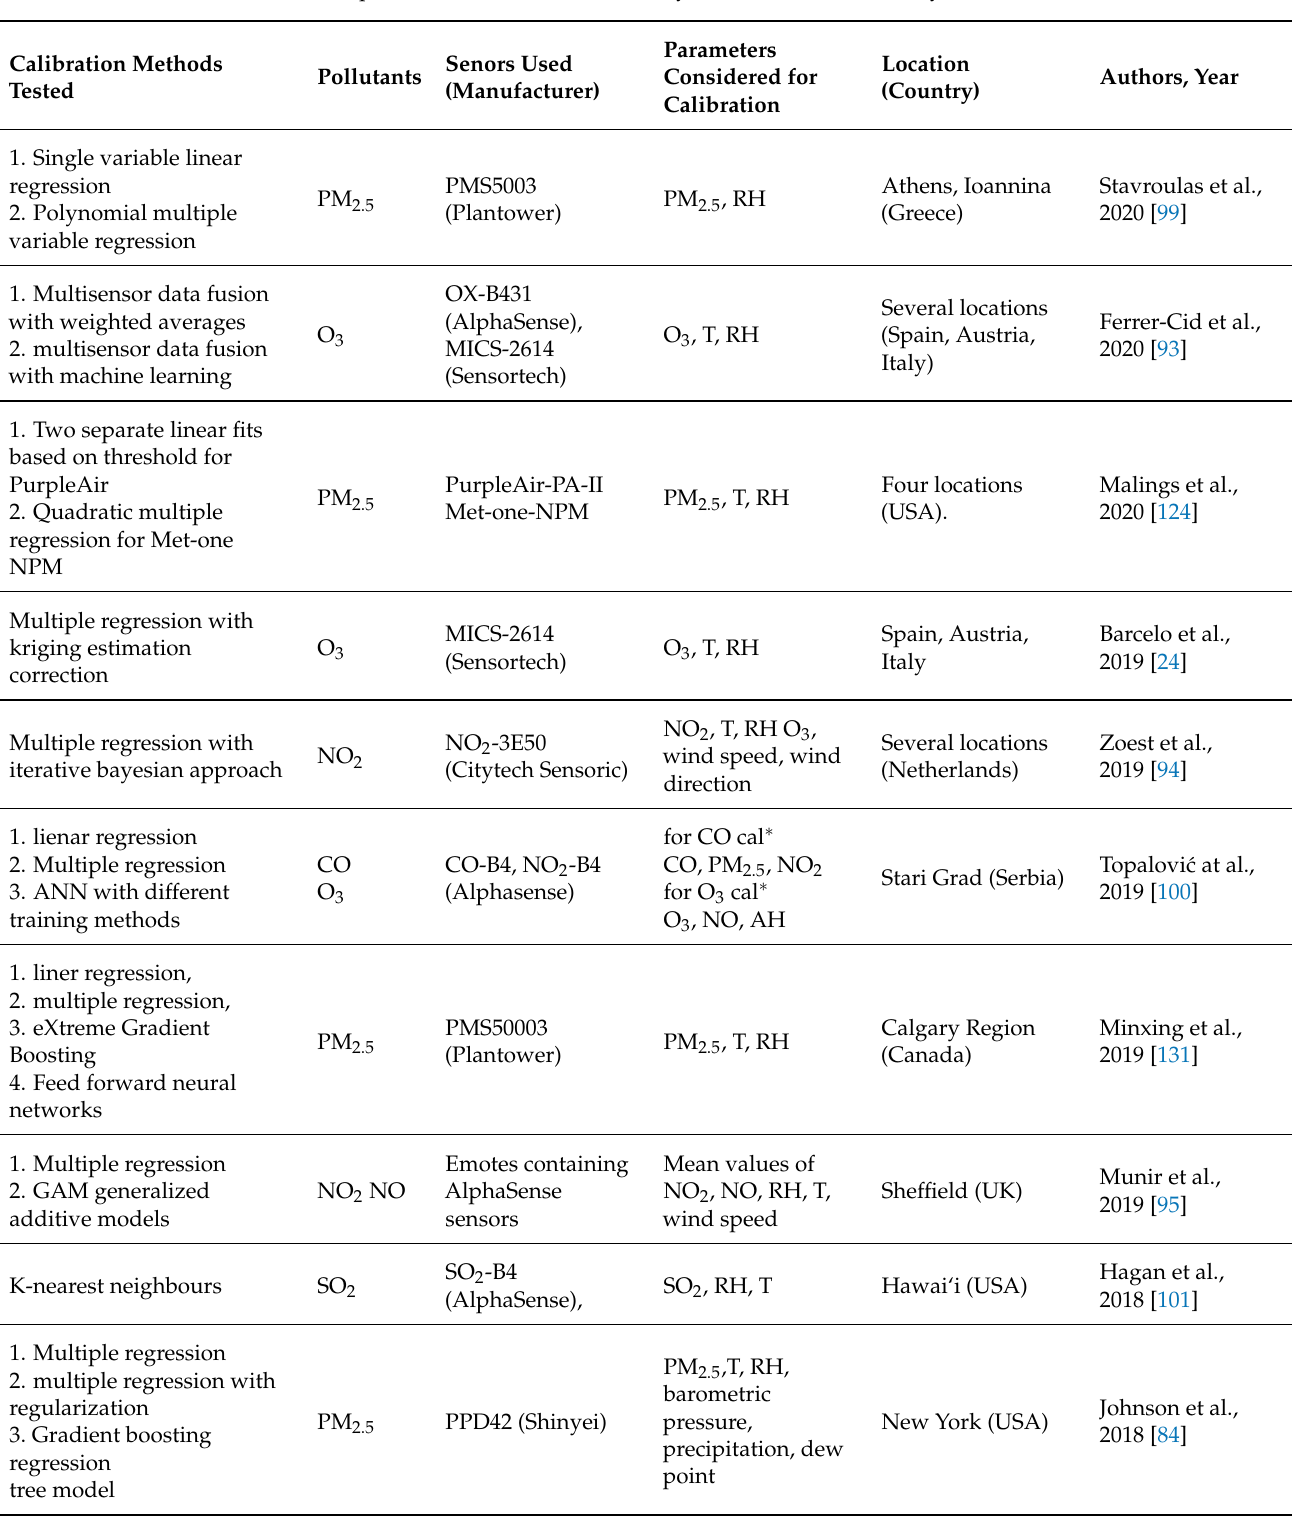
Table 7. In field calibration models tested with various sensors at different locations. Here, T is Temperature, RH is relative humidity, AH is absolute humidity, cal ∗ is